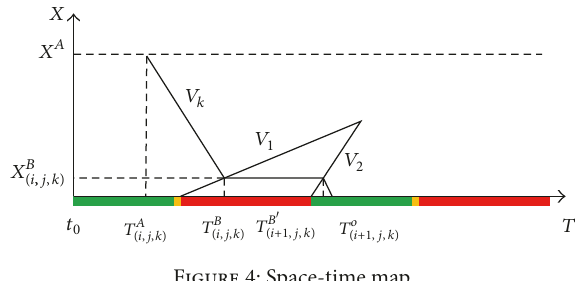
Figure 4: Space-time